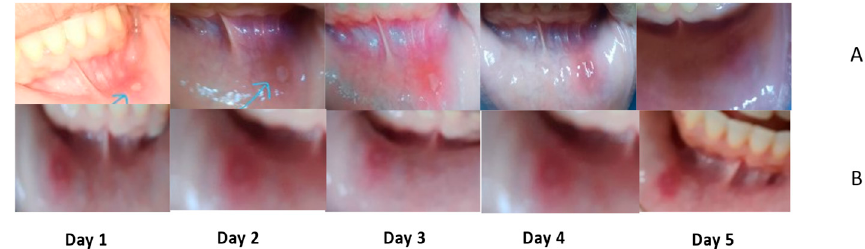
The efficiency of CoBFDF in relieving pain and wound healing is clear in Figure 11.